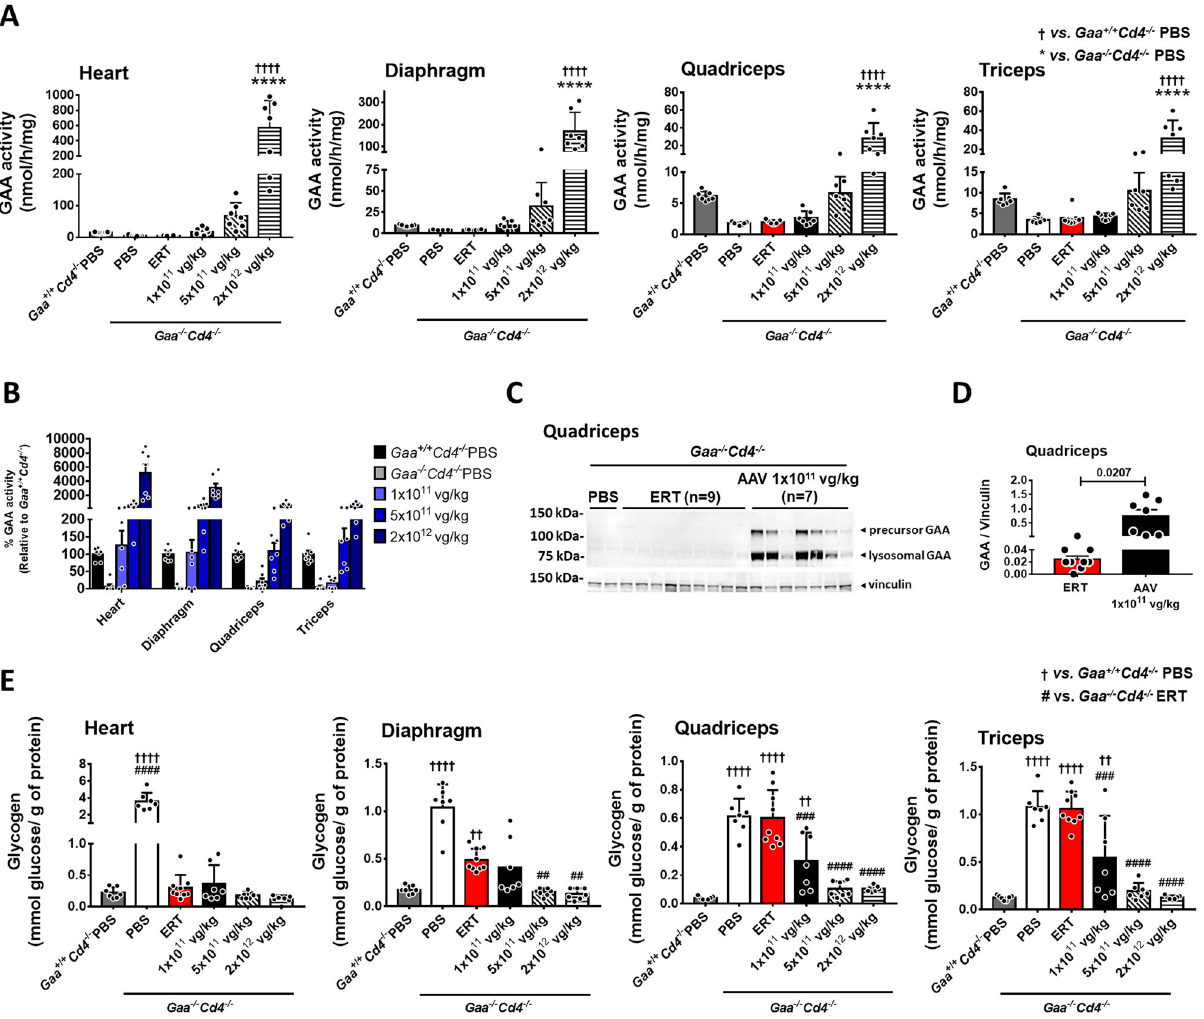
Fig. 2 AAV-GAA gene transfer results in ef fi cient GAA uptake and glycogen clearance in muscle. A Analysis of GAA activity in muscles at sacri fi ce. B Comparison of GAA activity in different muscle groups. C Comparison of lysosomal GAA at sacri fi ce in quadriceps of mice treated with enzyme replacement therapy (ERT) vs. AAV-GAA gene transfer at 1 × 10 11 vg/kg. D Quanti fi cation of the lysosomal GAA bands depicted in C . E Analysis of glycogen content in muscles at sacri fi ce. PBS-injected Gaa + / + Cd4 − / − and Gaa − / − Cd4 − / − mice were used as controls. Data shown as average ±